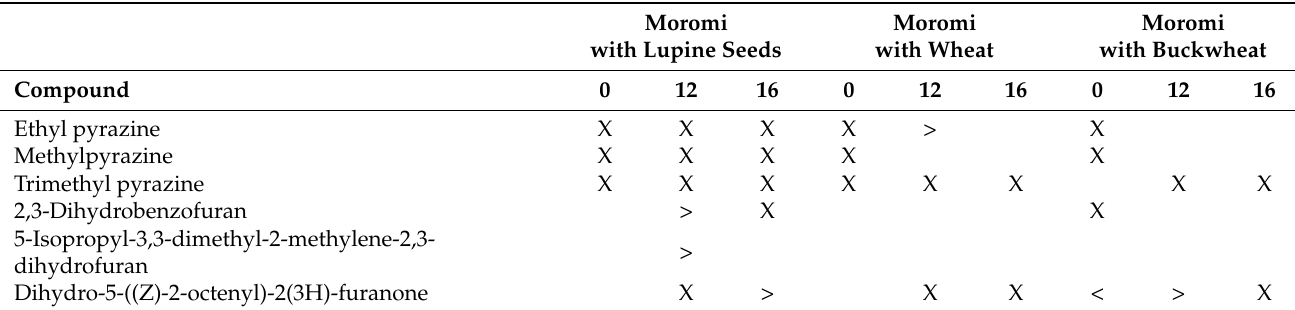
X Compound was detected in both replicates of the fermentation. > Compound was detected in the first replicate. < Compound was detected in the second replicate. At the beginning, a number of different pyrazines were determined. However, they were metabolised during the fermentation with additional carbohydrate sources. The